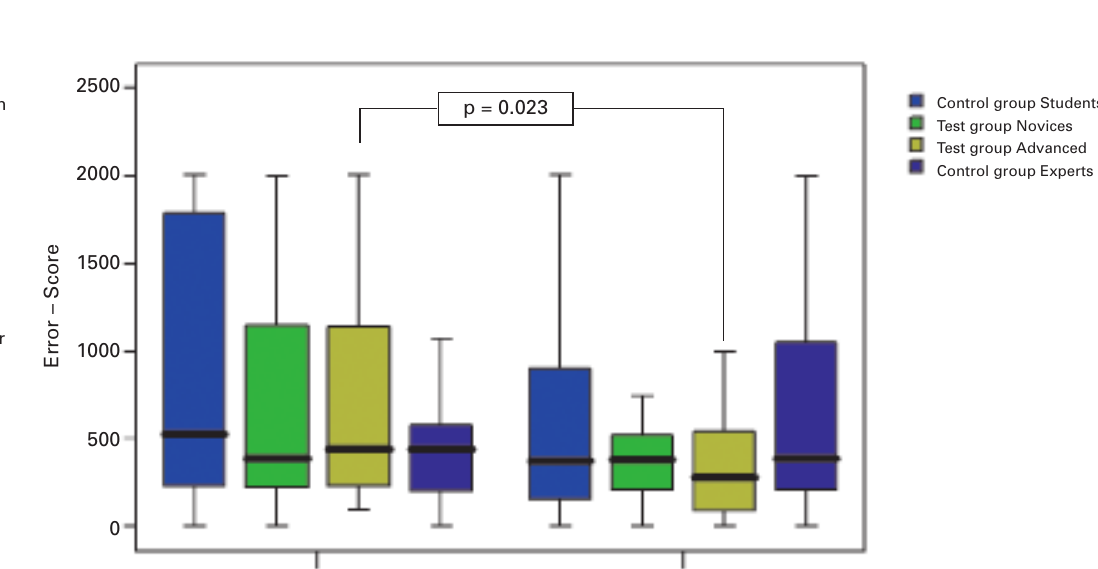
Figure 1 Box plots show mean and standard devia- tion of the time in seconds needed for completion of the clip application on the LapSim for the test and the control groups. Only ad- vanced residents in the test group be- came significantly faster after the practi- cal course (Kruskall- Wallis test; p = 0.019).